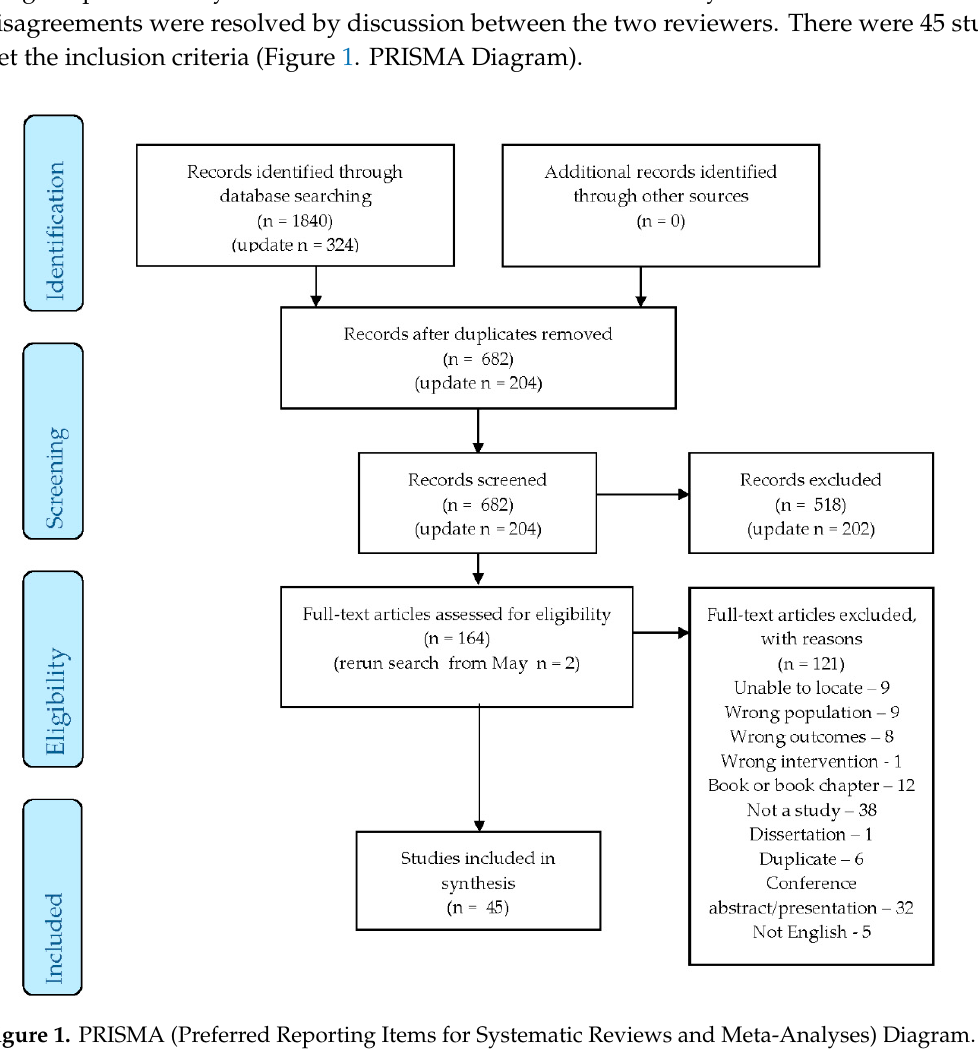
Figure 1. PRISMA (Preferred Reporting Items for Systematic Reviews and Meta-Analyses) Diagram.